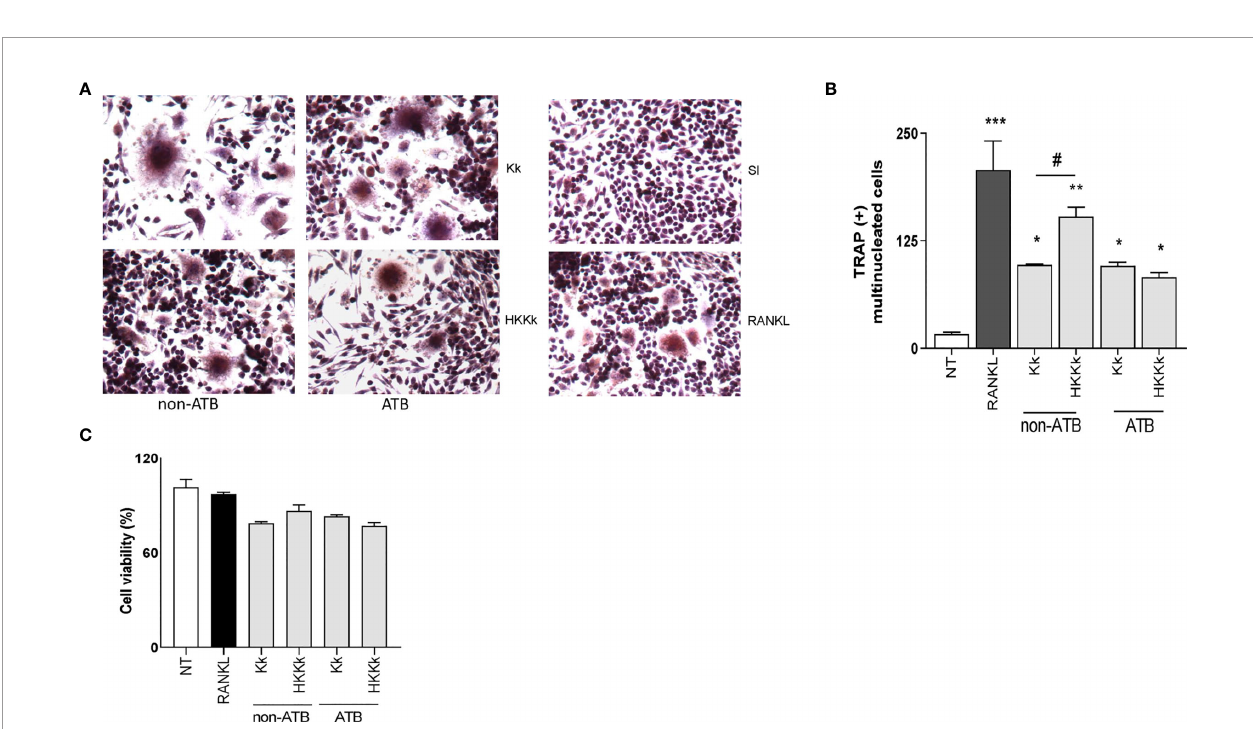
FIGURE 8 | Kingella kingae induces osteoclast differentiation. RAW 264.7 cells were infected with K. kingae (multiplicity of infection = 1) and HKKk (1 × 10 5 bacteria/ ml) added in conjunction with macrophage colony-stimulating factor without antibiotics (non-ATB). In some wells, the cells were washed, and new culture medium containing antibiotics was added after 2 h (ATB). After 7 days, osteoclastogenesis was determined by the generation of TRAP-positive multinucleated cells (more than three nuclei). Representative digital images were taken by light microscopy (A) , and TRAP-positive multinucleated cells were identi fi ed and counted (B) . Cell viability was measured by MTT colorimetric assay; results were expressed as percent of control (NT cells) (C) . RANKL was used as a positive control. NT, non- treated. Graphics are showing values obtained from three independent experiments. Data are given as mean ± SD. * P < 0.05; *** P < 0.001 versus NT. # P <